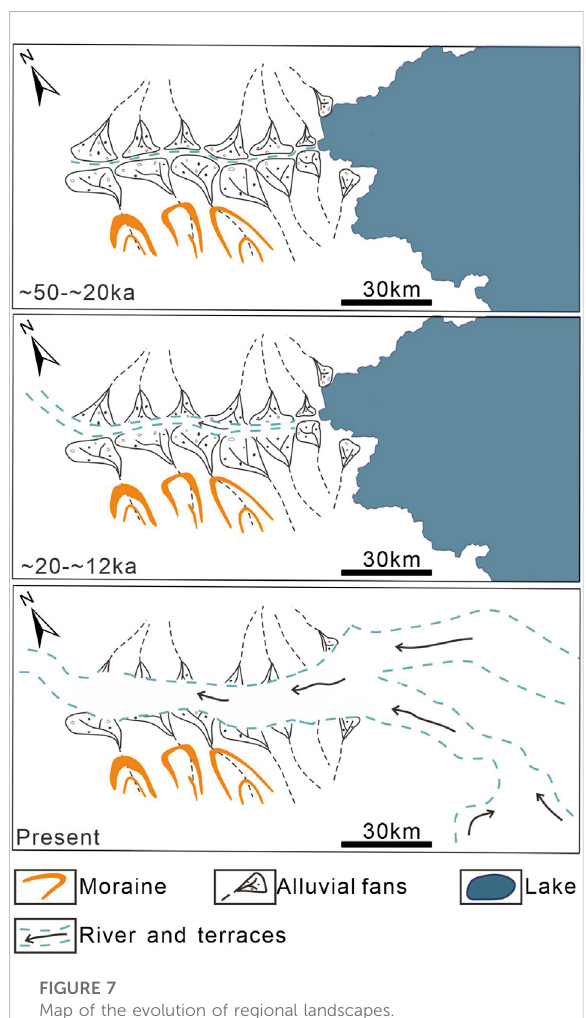
FIGURE 7 Map of the evolution of regional